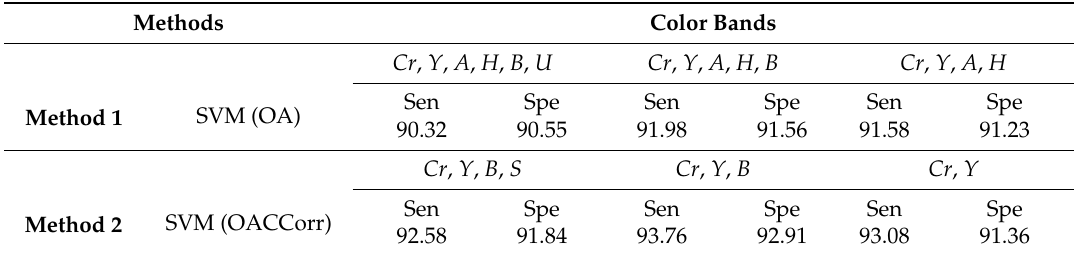
Table 2. Sensitivity, specificity, and accuracy using SVM